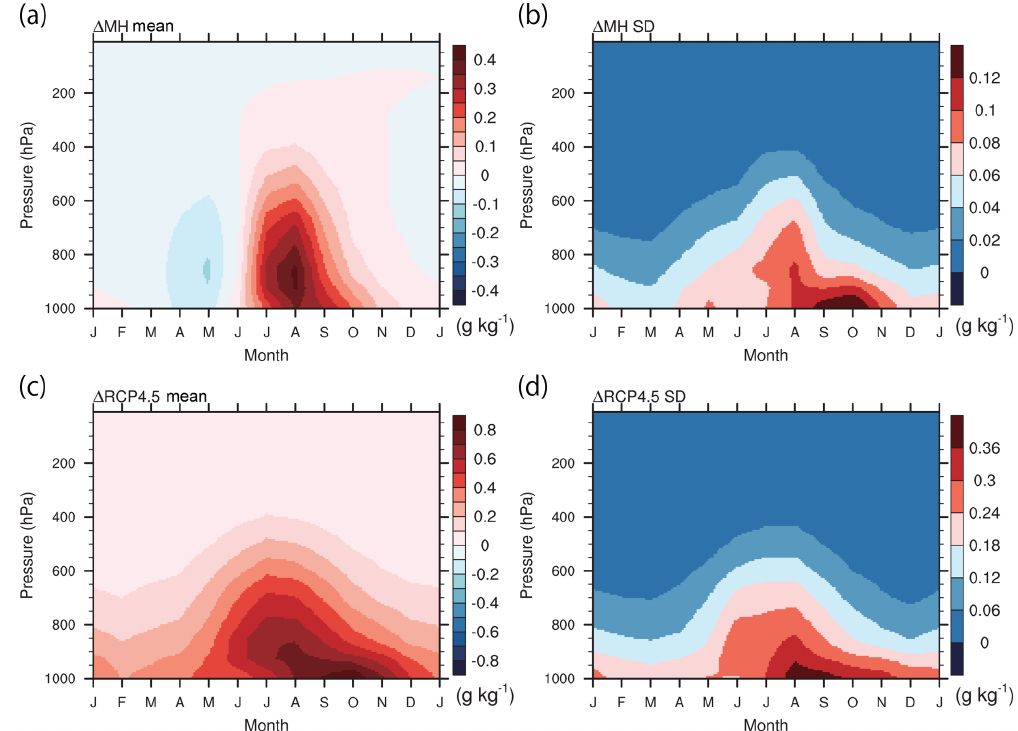
Figure 8. Same as in Fig. 6 but for the specific humidity change (gkg − 1 ) (north of 60 ◦ N). All 10 models listed in Table 2 are used. (Note that the figure appears blocky compared to Fig. 6 due to the use of a different interpolation scheme in the plotting software which was chosen to avoid a technical issue for pressure coordinate, but it is irrelevant to the